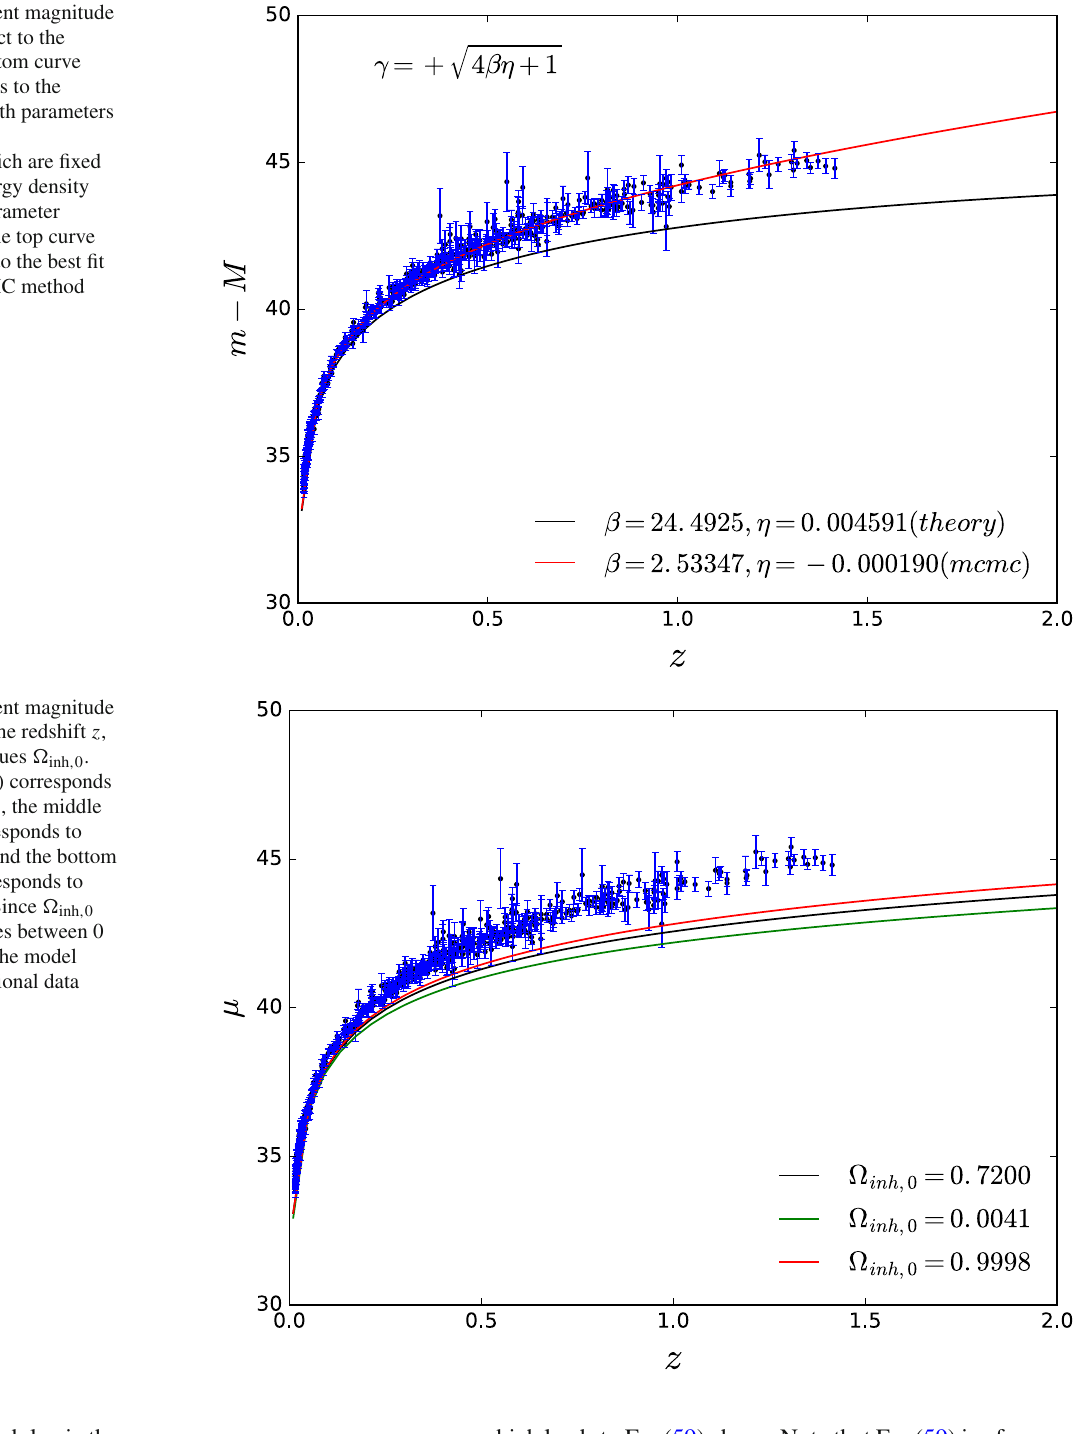
Fig. 2 The apparent magnitude m − M with respect to the redshift z . The bottom curve (black) corresponds to the Stephani model with parameters β = 24 . 4925 and η = 0 . 004591, which are fixed to satisfy dark energy density and the Hubble parameter simultaneously. The top curve (red) corresponds to the best fit obtained via MCMC method